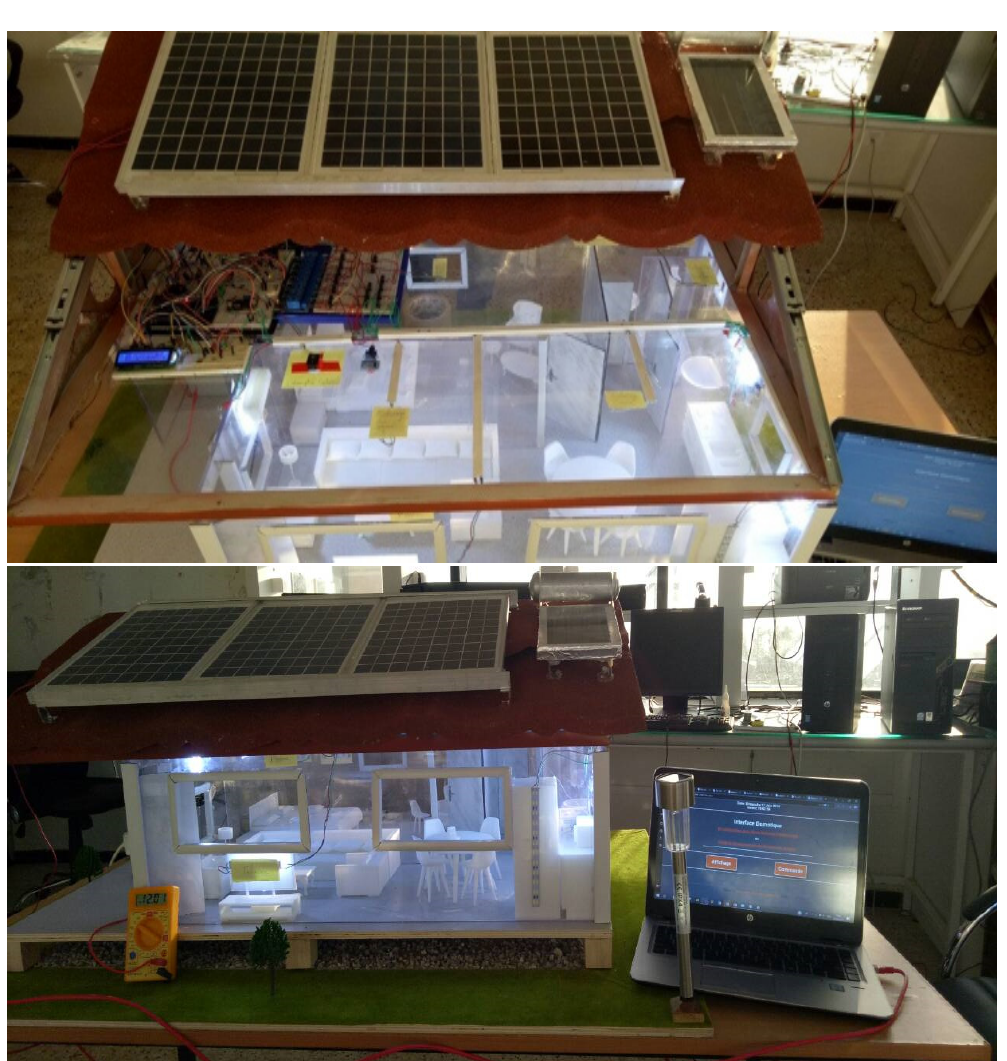
Figure 11. Photovoltaic panels.